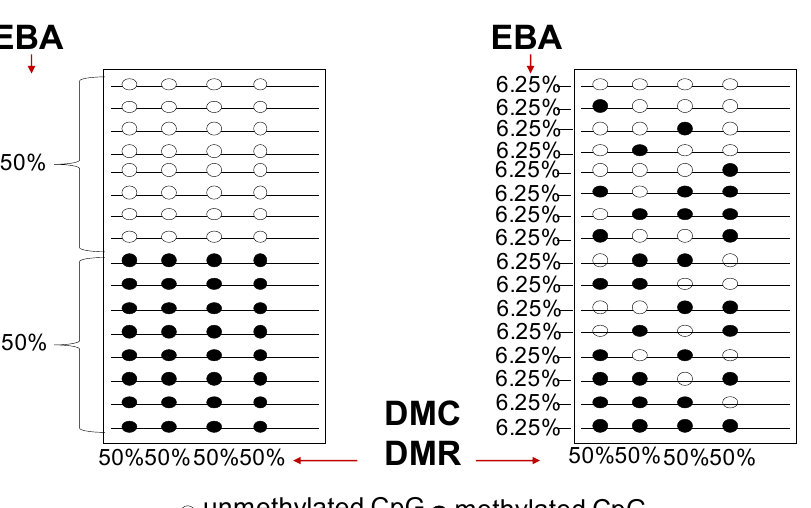
Figure 4. Differential methylated regions (DMC) and epiallele-based (EBA) analysis. Two populations of epialleles are reported on the right and left: the first population on the left is composed by two subpopulations equally represented (one fully methylated at the 4 CpGs and the other unmethylated). The second population on the right is composed by epialleles with differentially heterogeneous methylated CpGs with the same frequency 6.25%.